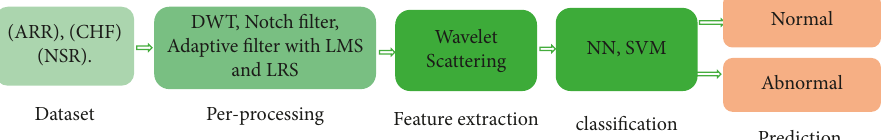
Figure 3: The general system of classification.